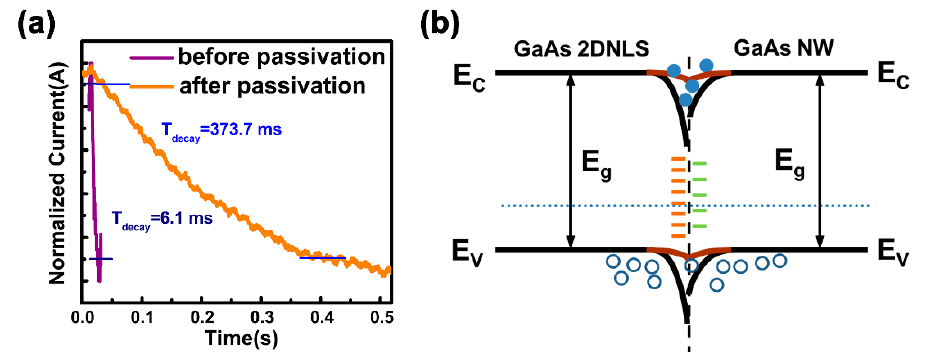
Figure 5. ( a ) Comparison of the decay time before and after passivation at 8 V. ( b ) Band structure of the mixed-dimensional GaAs photodetector before and after passivation.